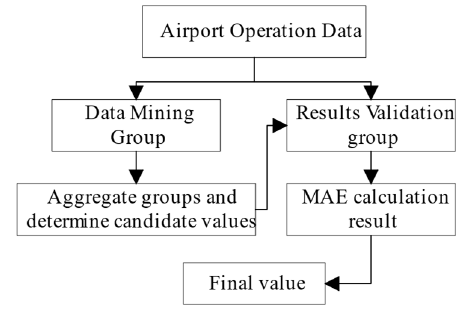
Figure 7. Process of empirical taxi time